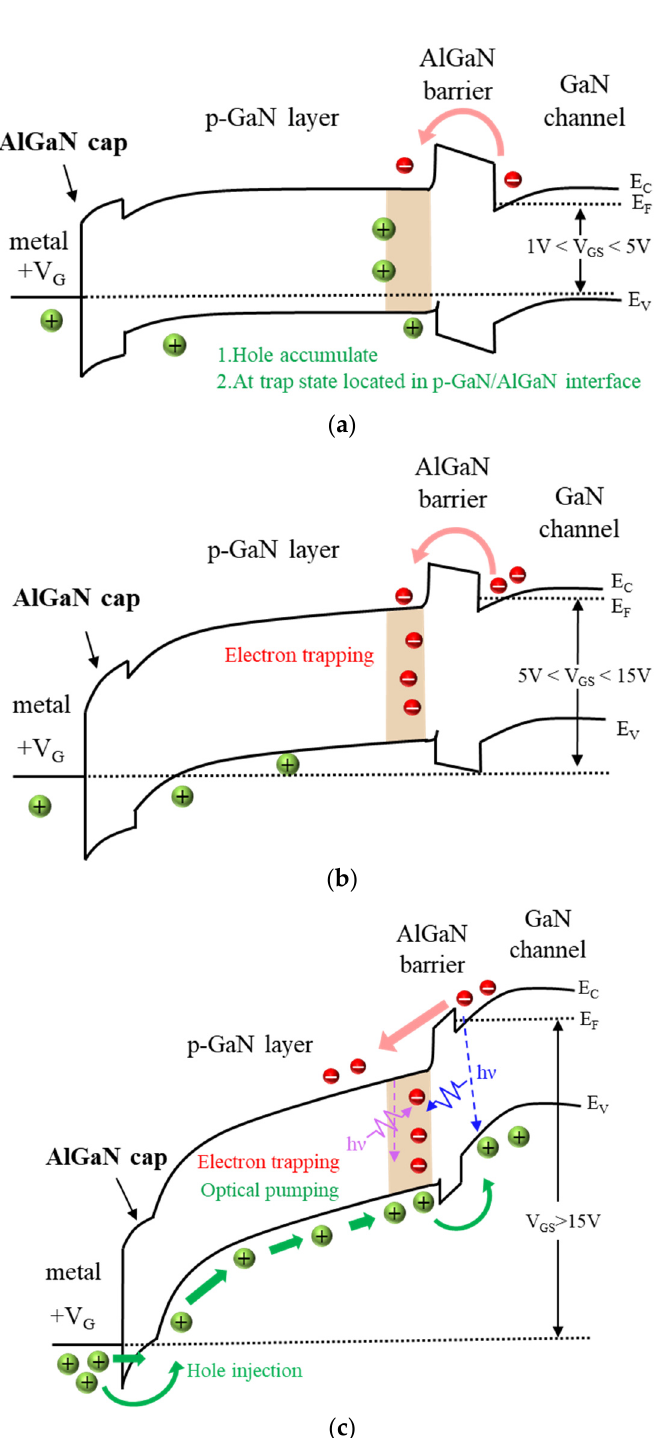
Figure 6. Schematic of the band diagram gate region of a p-GaN HEMT operating at ( a ) 1 V < V GS < Schematic of the band diagram gate region of a p-GaN HEMT operating at 5 V, ( b ) 5 V < V GS < 15 V, and ( c ) V GS > 15 V. ( a ) 1 V < V GS < 5 V, ( b ) 5 V < V GS < 15 V, and ( c ) V GS > 15